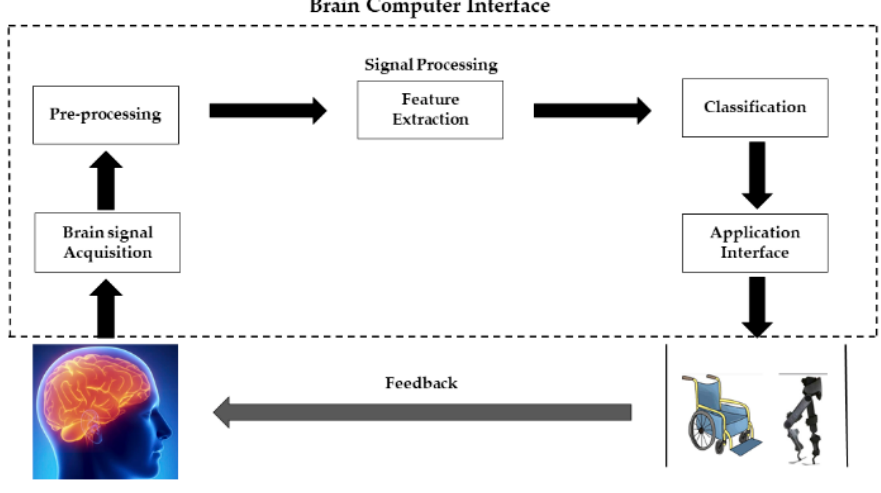
Figure 1. Block diagram of BCI system.